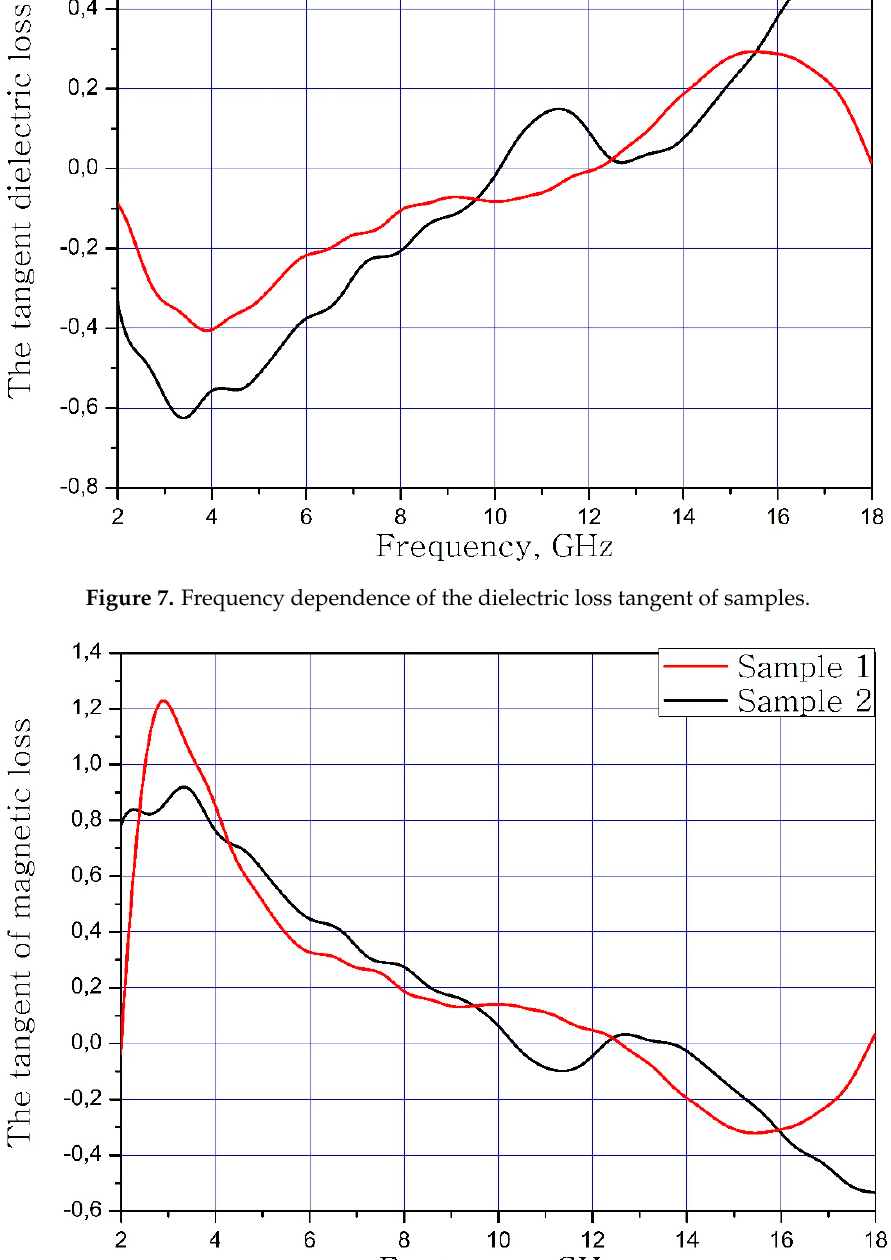
Figure 8. Frequency dependence of the tangent of magnetic loss samples.